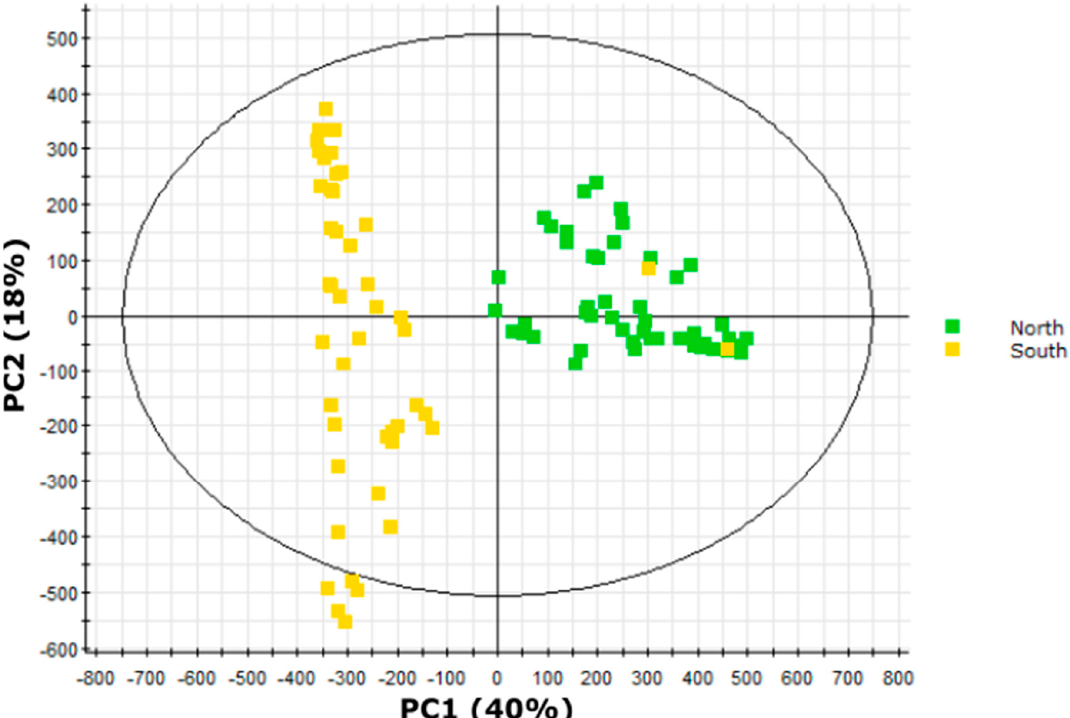
Figure 5. Principal component analysis (PCA) scores plot of samples from 16 S. pennellii accessions from across Peru separated by abundances of 54 metabolite features identified in trichome extracts by UHPLC–HR-MS. Samples from the North range are indicated in green, while samples from the South range are indicated in yellow (see Figure 2 for details on geographic range). Principal component 1 (PC1) accounted for approximately 40% of the variance in the dataset and drove strong separation between north and south accessions, while PC2 accounted for 18% of the variance and associated primarily with variation within the south range Table 4. Orthogonal partial least squares/projection to latent structures discriminant analysis (OPLS– DA) model performance. The table indicates the percentage of test samples that each model classified correctly, incorrectly, or was unable to classify.